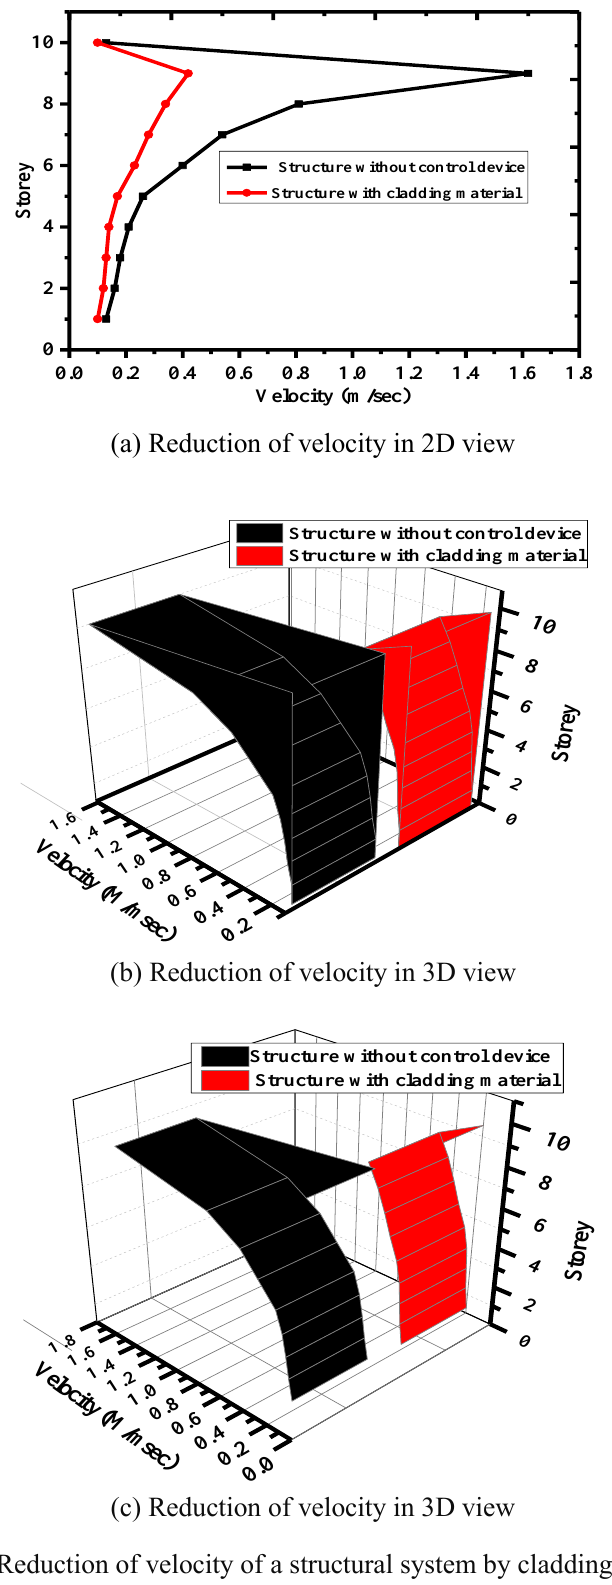
Fig. 9. Reduction of velocity of a structural system by cladding